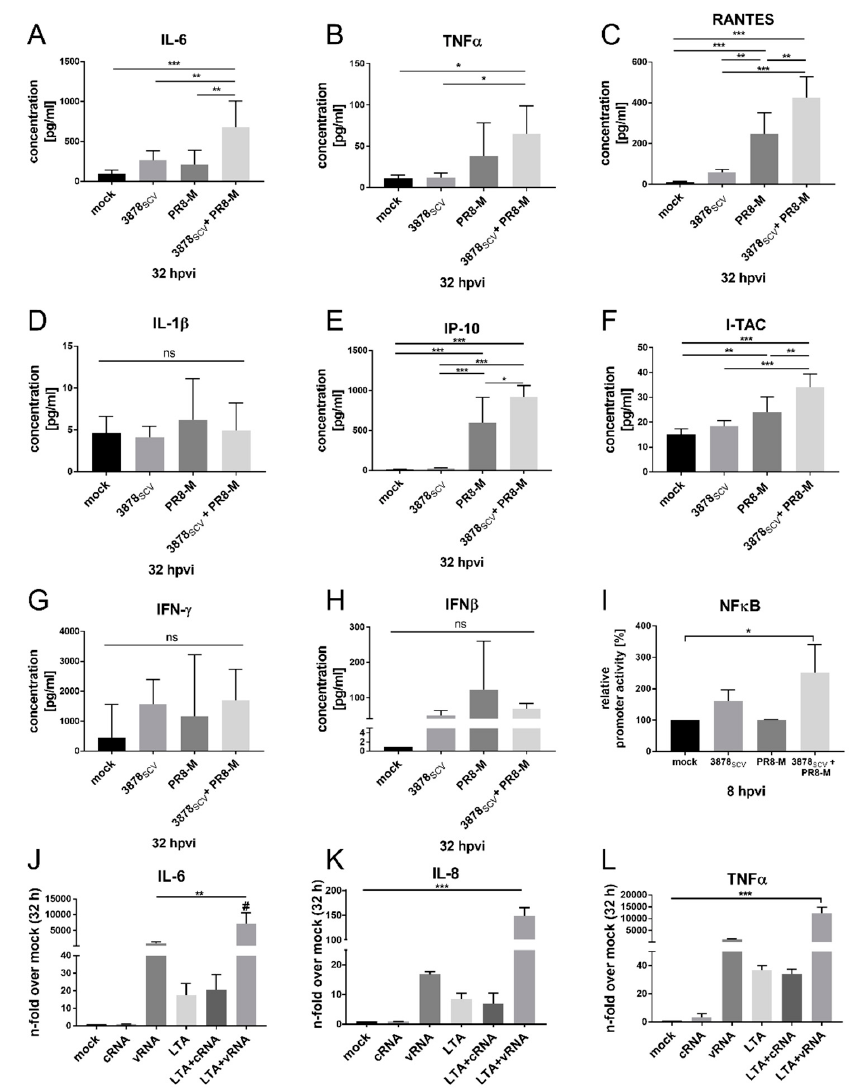
Figure 5. Secretion of the pro-inflammatory cytokines and chemokines are enhanced after S. aureus 3878 SCV colonization and subsequent IV PR8-M infection regulated by TLR2- and RIG-I-mediated NF κ B promoter activation. ( A – H ) A549 human lung epithelial cells were infected with S. aureus 3878 SCV (MOI = 0.01) for 24 h and / or super-infected with IV PR8-M (H1N1; MOI = 0.1) for 32 h. Afterwards, supernatants were collected to measure the concentration of secreted proteins via FACS analysis. Means + SD of three independent experiments, including technical duplicates, are